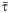
(a) Graphs of τ¯ and L versus θ0 for each of the two buses. These simulation results agree with Eqs (4) and (5), as well as the lower bound θmin from Eq (7). Shown here [as well as in (b)] is for k = 1/16, and these features similarly hold for any value of (fixed) k. (b) Graphs of Δθ(t) versus time for each of the two buses. The no-boarding policy kicks in if Δθ > 225°.